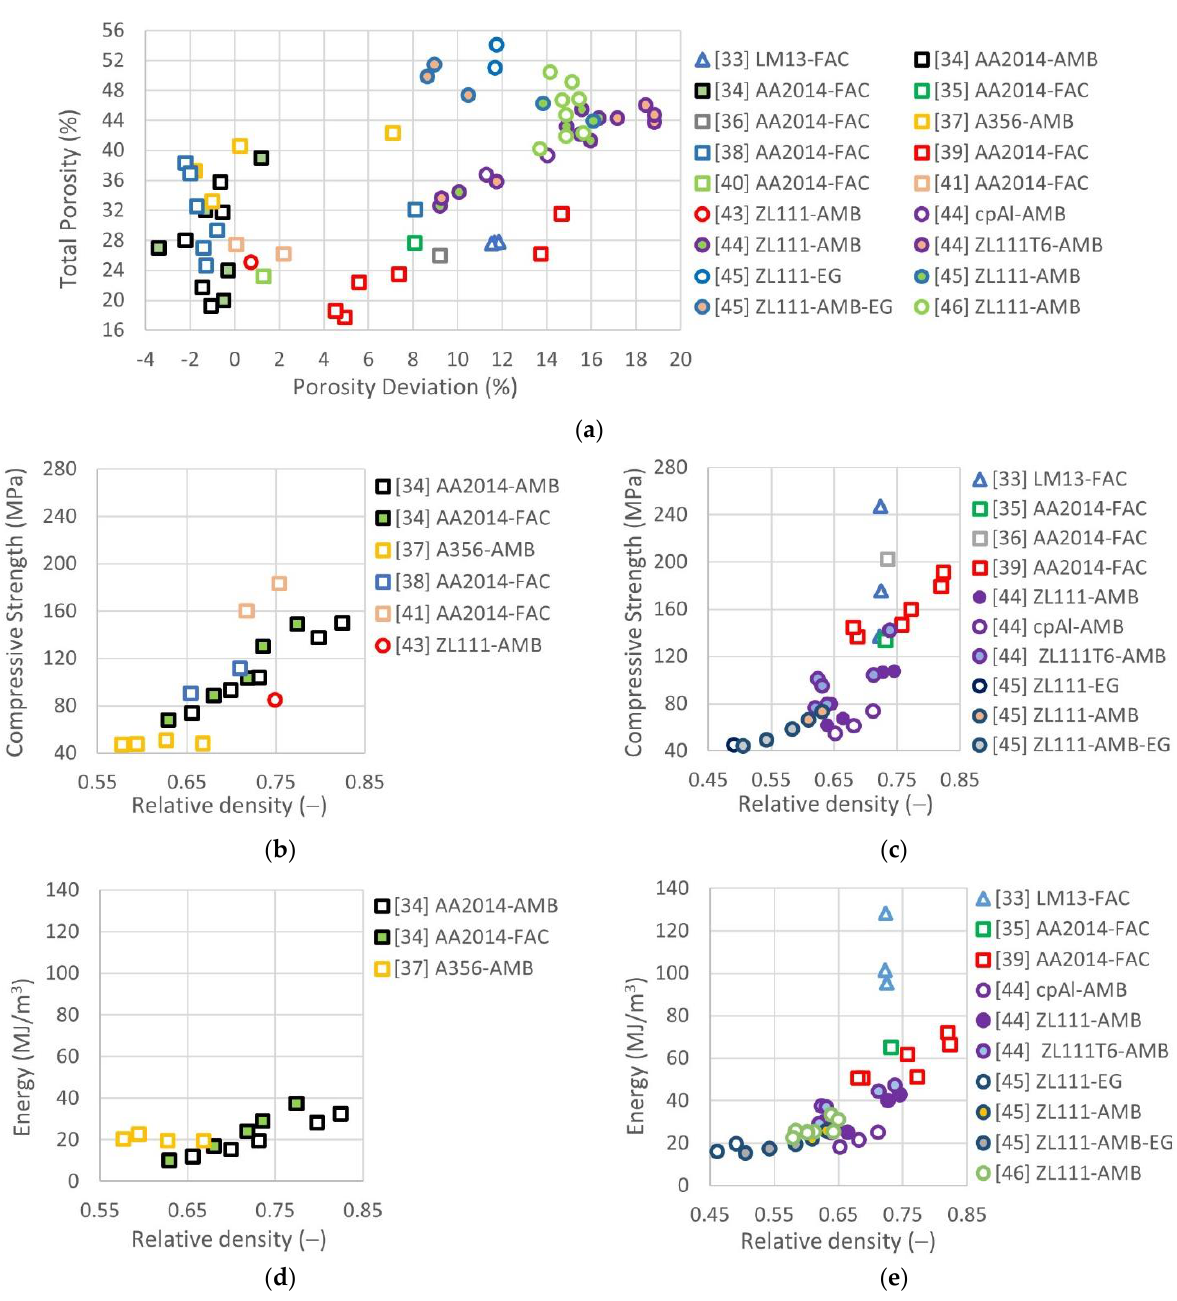
Figure 7. Properties of Al alloy MMSFs processed by SCTs. ( a ) Experimental total porosity and deviation in porosity from theoretical values computed by the rule of mixtures (ROM). ( b ) Compressive strength of MMSF within the ± 4% porosity deviation range. ( c ) Compressive strength of MMSF outside the ±4% porosity deviation range. ( d ) Absorbed energy of MMSF within the ±4% porosity deviation range. ( e ) Absorbed energy of MMSF outside the ±4% porosity deviation range.